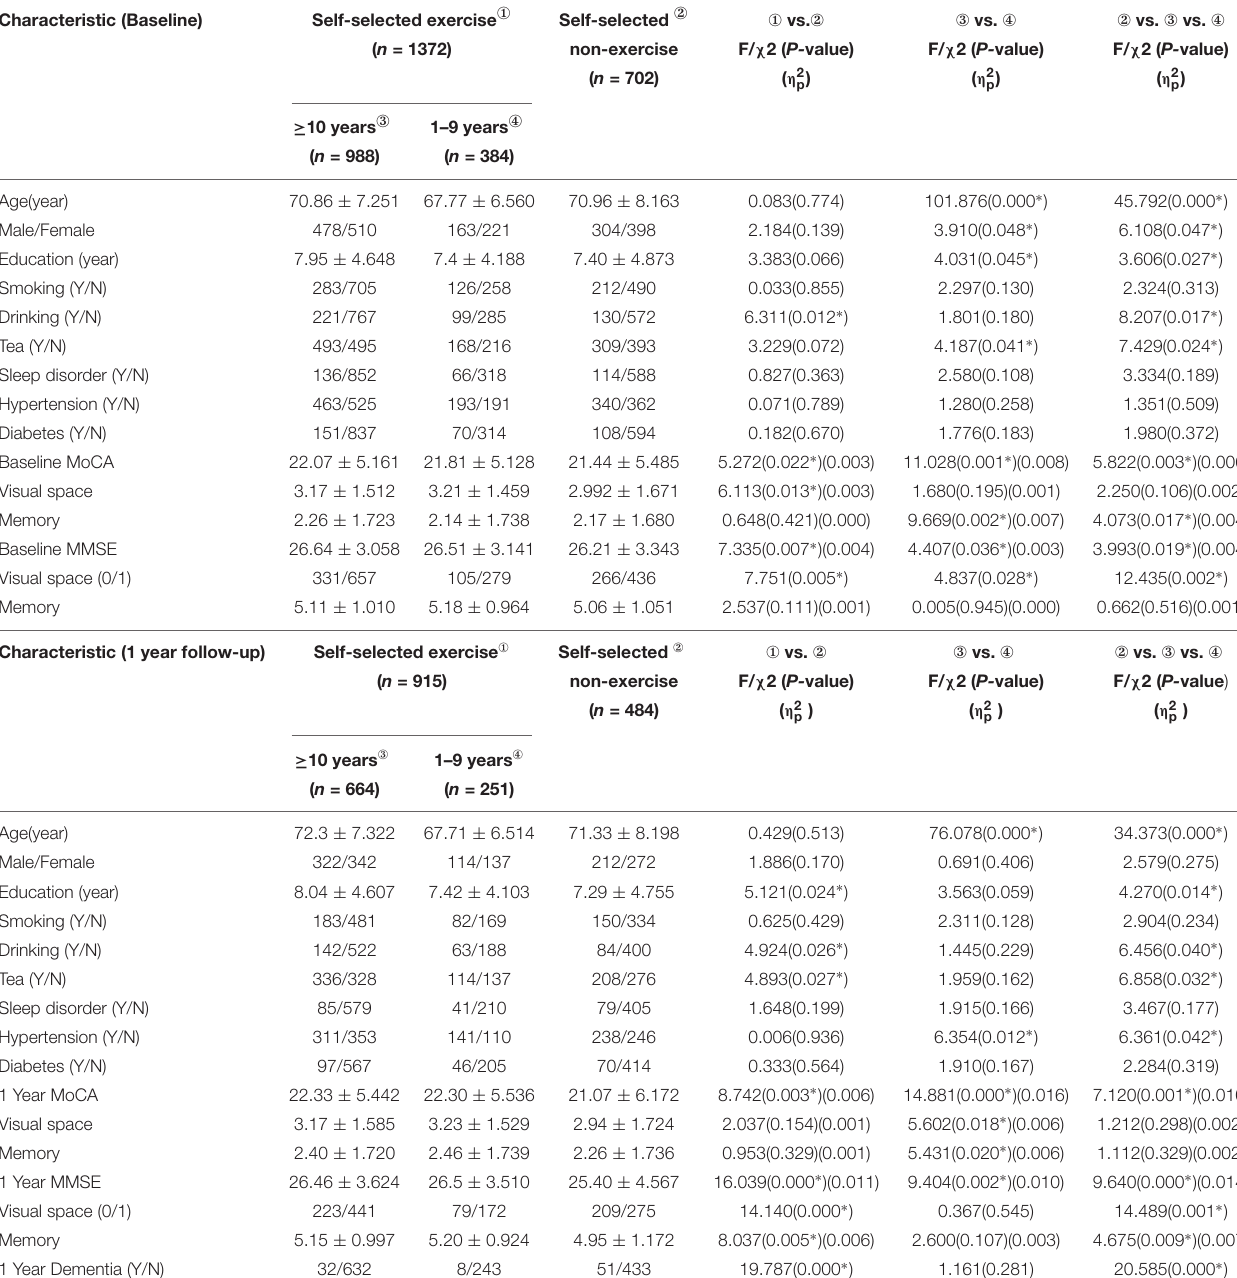
TABLE 1 | Demography, life style, physical diseases, and cognitive function in the overall database of study participants in non-dementia elderly Chinese population. Characteristic (Baseline) Self-selected exercise